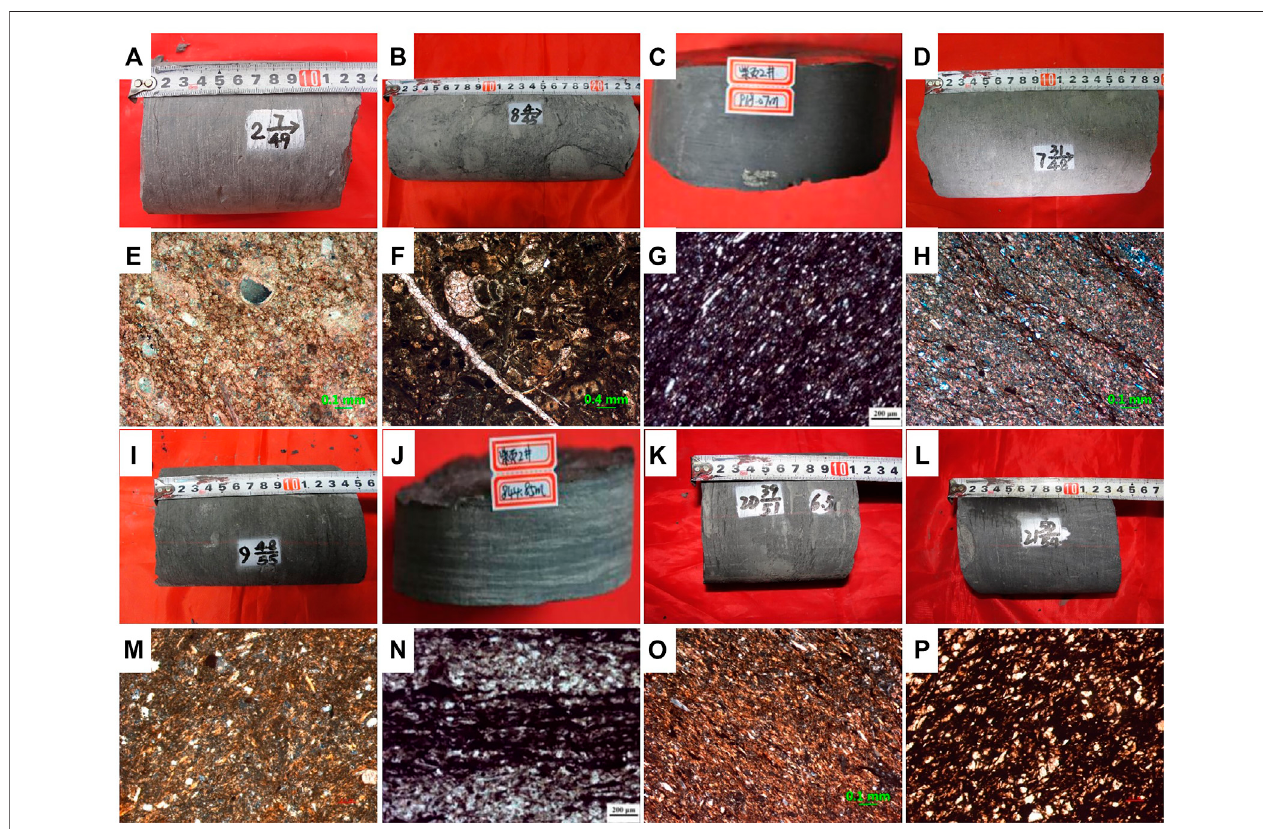
FIGURE3| Various lithologies oftransitional shales in theUpper CarboniferousKelukeFormation. (A,E) :Limestone, dominated by recrystallized calcite with minor bioclastic. (B,F) : Argillaceous bioclastic limestone. (C,G) : Black laminated argillaceous siltstone, pyrite. (D,H) : Calcareous mudstone. (I,M) : Gray black silty mudstone. (J,N) : Black striped argillaceous siltstone. (K,O) : Mudstone. (L,P) : Gray black silty carbonaceous mudstone.